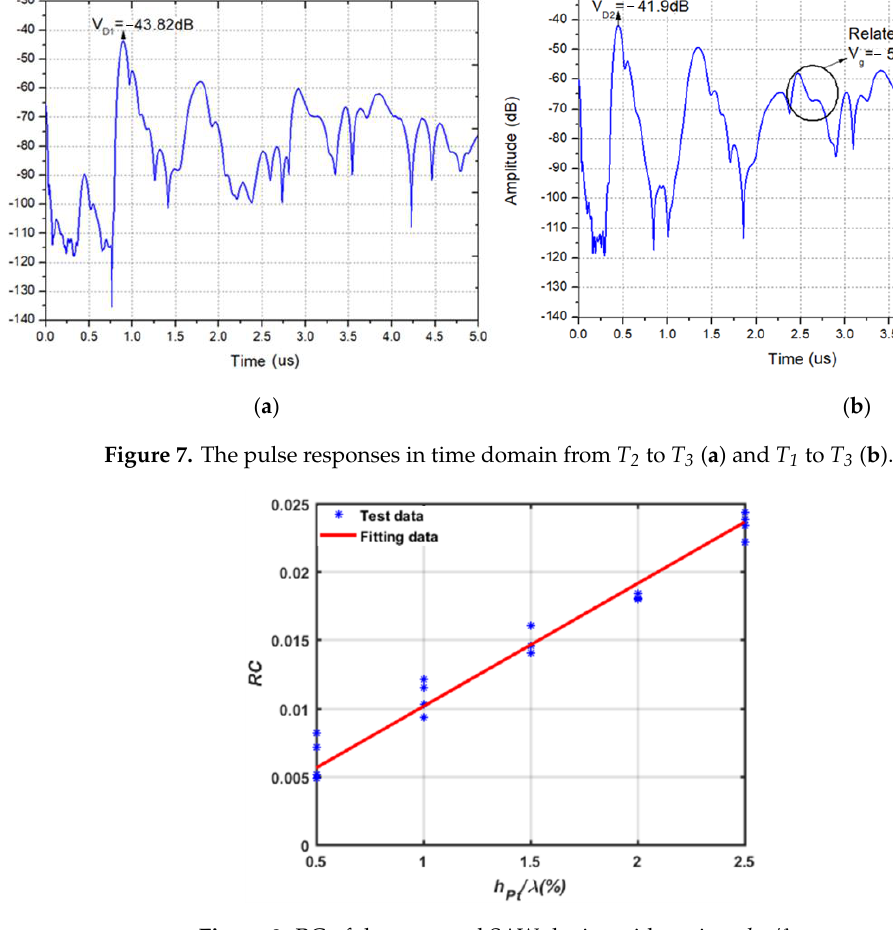
Figure 8 . RC of the prepared SAW device with various h pt /λ . 2.2. Extraction of Other Relevant Parameters With the exception of the reflection coefficient, other relevant parameters for COM simulation, i.e., propagation velocity v , coupling coefficient κ , excitation coefficient α , and static capacitance C, as defined by Equations (9) – (11), were extracted by the three-dimensional finite element method (FEM) method.